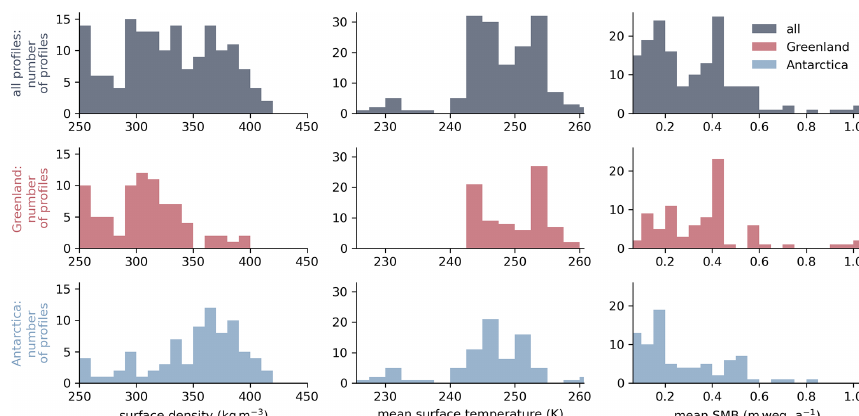
Figure 4. Distribution and comparison of boundary conditions at the 159 firn profile sites. All values are averaged over the simulation time for each location, beginning in 1958 and 1979 for Greenland and Antarctica, respectively, and ending at the date of measurement (see Sect. 3.2). The top row of plots (gray) shows the boundary conditions at all locations, whereas the middle and bottom rows, in red and blue, show only the locations in Greenland and Antarctica, respectively. Data for the surface temperature (center) and surface mass balance (right column) are provided by RACMO2.3 (Van Wessem et al., 2014; Noël et al.,